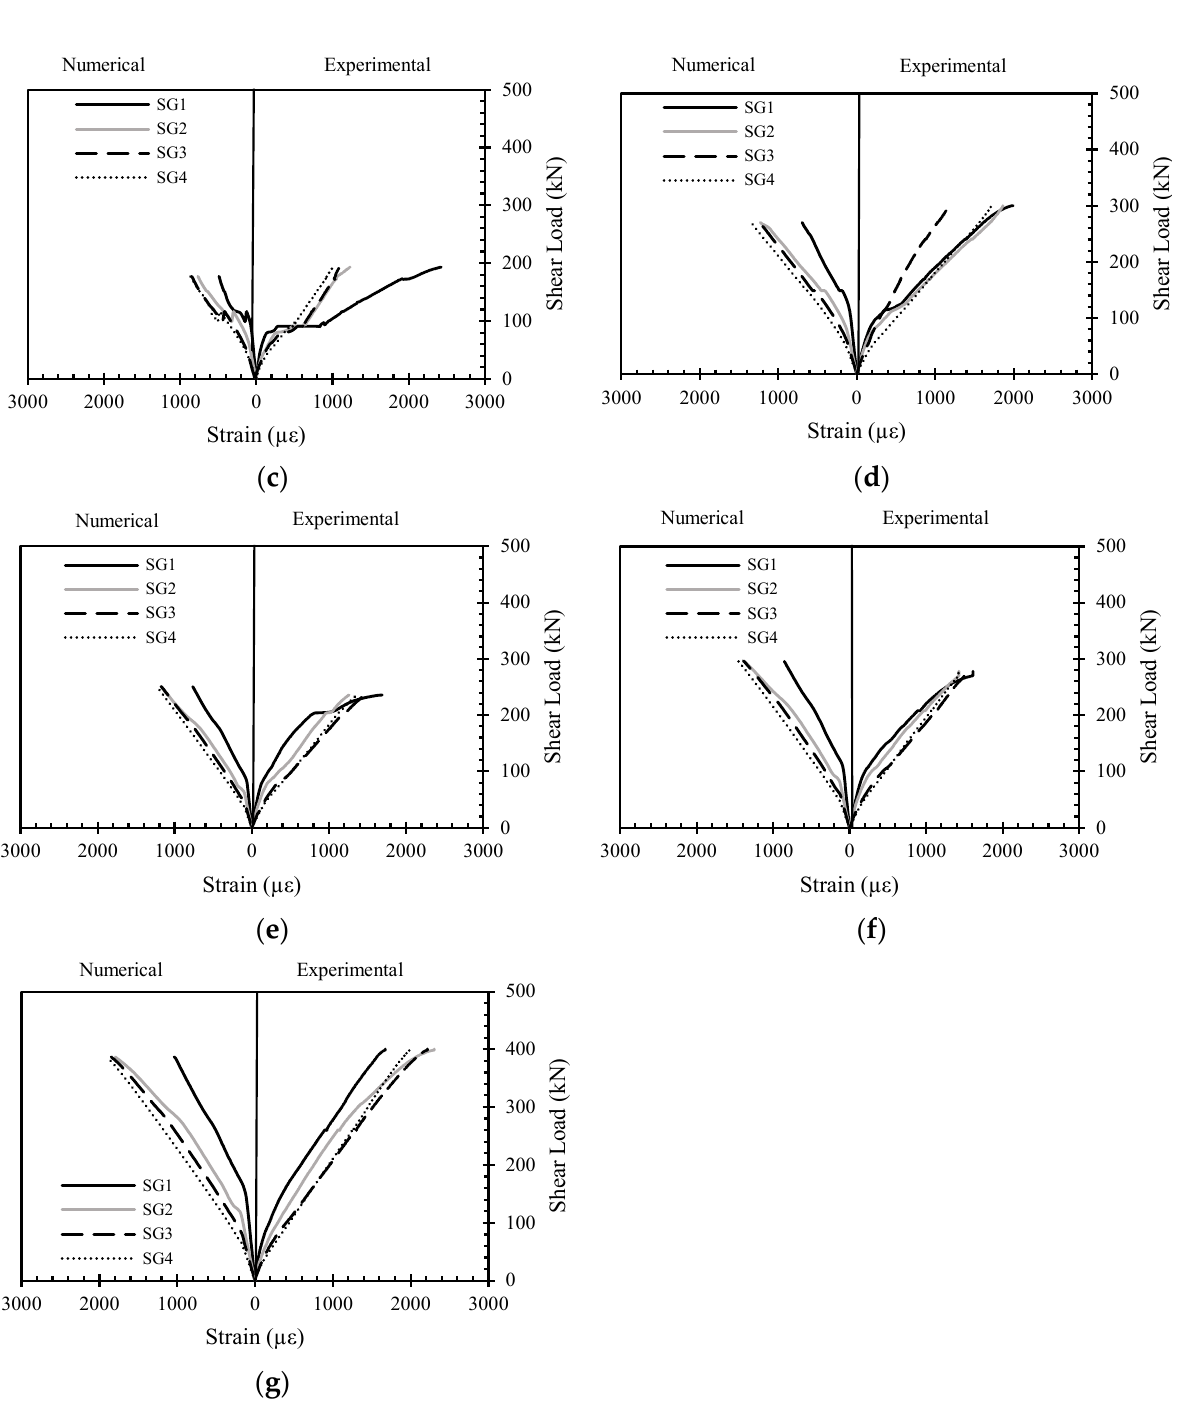
Figure 12. Numerical and experimental steel strain responses of group S: ( a ) SR0-SF0; ( b ) SR0-SF0-S; ( c ) SR100-SF0; ( d ) SR100-SF0-S; ( e ) SR100-SF1; ( f ) SR100-SF2; and ( g ) SR100-SF3.